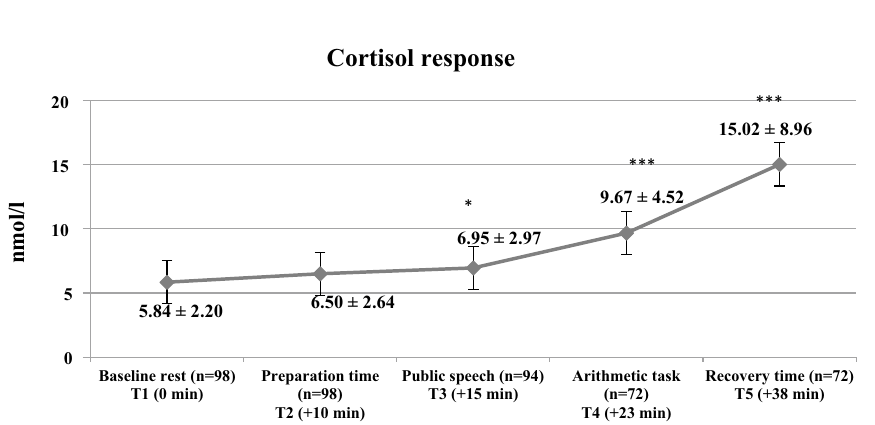
Figure 1. Descriptive statistics of cortisol measures and comparison with baseline cortisol measures during Trier Social Stress Test in the study participants. (*p < 0.05; ***p < 0.001 as compared with baseline